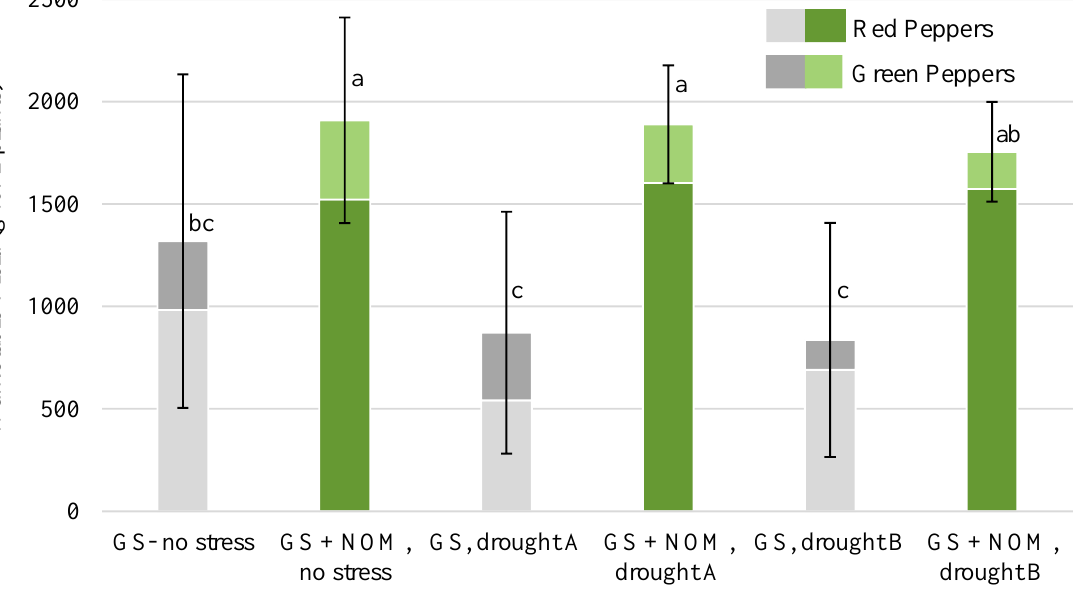
Figure 5. Average marketable pepper yield for red and green peppers during the drought stress trial for the grower standard (GS) with and without the NOM-based biostimulant, GS with and without the NOM-based biostimulant under drought A where water was stopped for 2 weeks shortly after plant establishment, and GS with and without the NOM-based biostimulant under drought B where water was stopped for 2 weeks at bloom. Values given are in grams for the summation of 2 plants, with six replicates per value. Means (for the total pepper count) with the same letter designation above each bar do not differ significantly ( p = 0.10, least significant difference), and error bars represent one standard deviation for the total pepper count. See also Supplementary Table S4, where ANOVA p values are each reported for red, green, and total pepper counts.